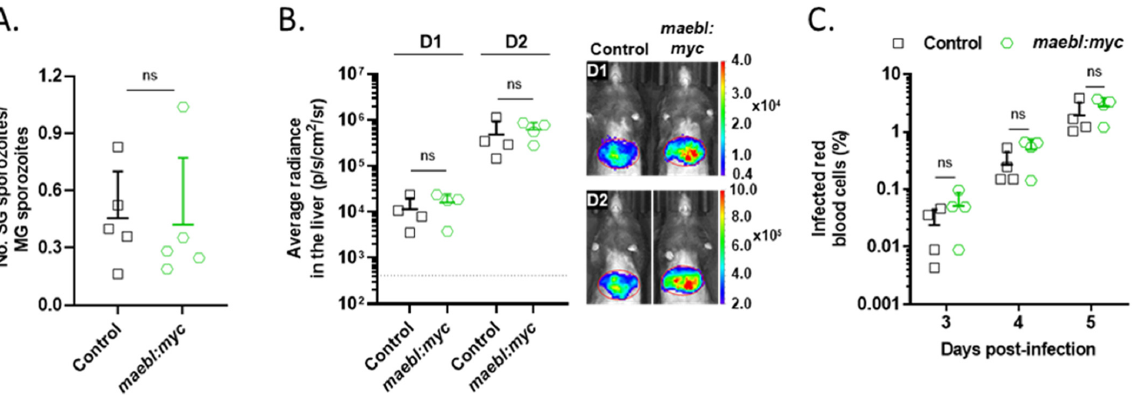
Figure 5. maebl:myc sporozoite infectivity to the mosquito and mammalian hosts. ( A ) Ratio of salivary gland (SG) sporozoites to midgut (MG) sporozoites in the Control and maebl:myc lines. Sporozoites were collected from mosquitoes on days 17 to 24 post-infection. Symbols represent the counts of independent experiments and bars indicate the mean + SD. Statistical significance was determined using unpaired t -test. ( B ) Infectivity of maebl:myc sporozoites to C57BL/6 mice by intravenous inoculation with 2.0 × 10 4 Control or maebl:myc salivary gland sporozoites. Left: parasite burden in the liver quantified as average radiance (photons/s/cm 2 /steradian) one (D1) and two (D2) days post-infection. Symbols represent values for individual animals and bars indicate the mean + SD ( n = 4). Dotted line: background level, calculated using non-infected mice. Statistical analysis was performed using unpaired t -test. Right : Representative images of the infected mice, on D1 and D2 post-infection. ( C ) Parasitemia of the infected mice, determined daily by a Giemsa-stained blood smear. Symbols represent values for individual animals and bars indicate the mean + SD. Statistical analysis was performed using unpaired t -test. ns, non-significant.